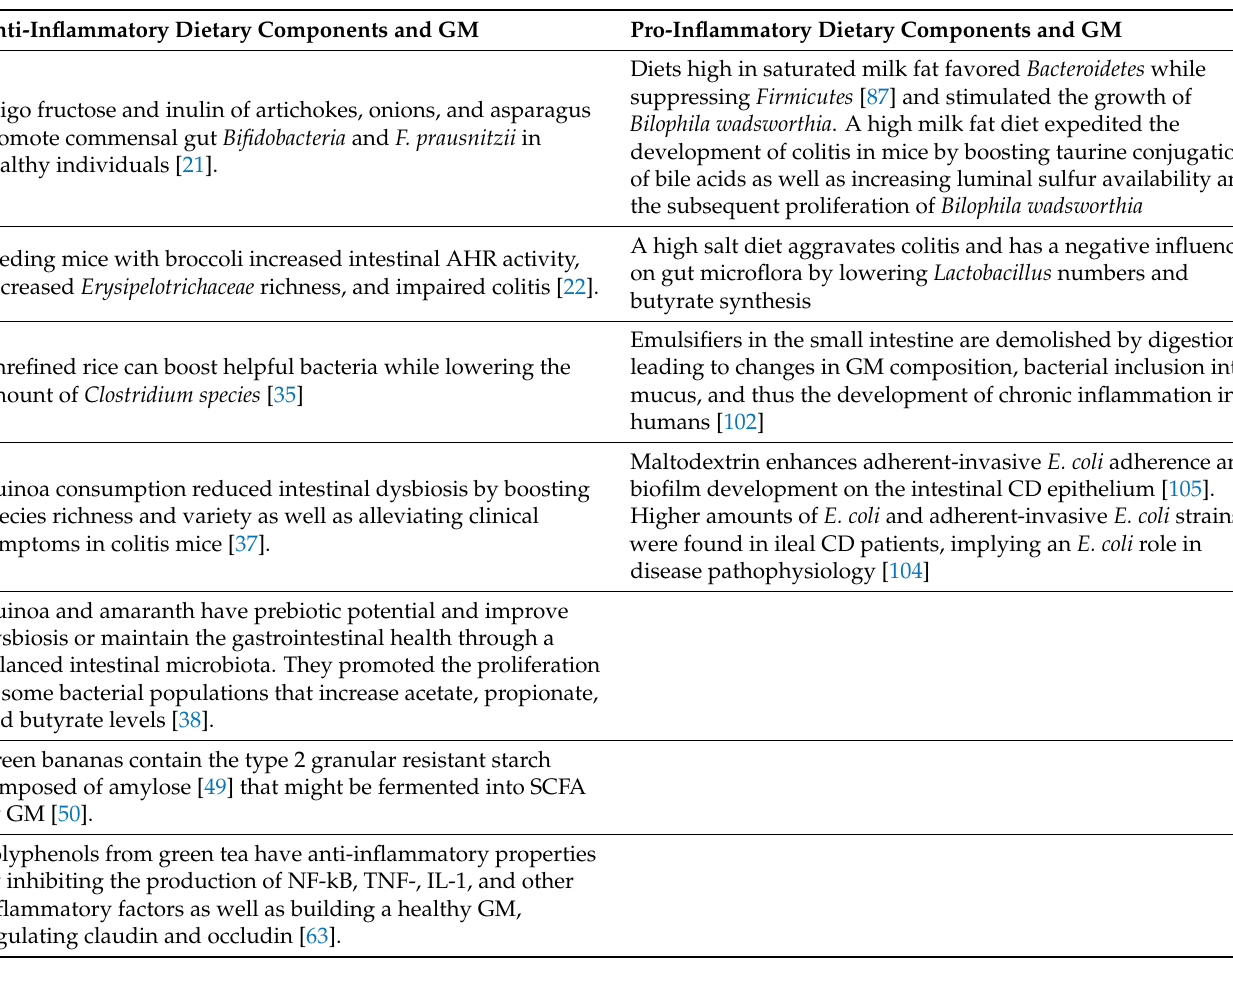
Table 2. Relevant findings of anti-inflammatory and pro-inflammatory dietary components on GM in